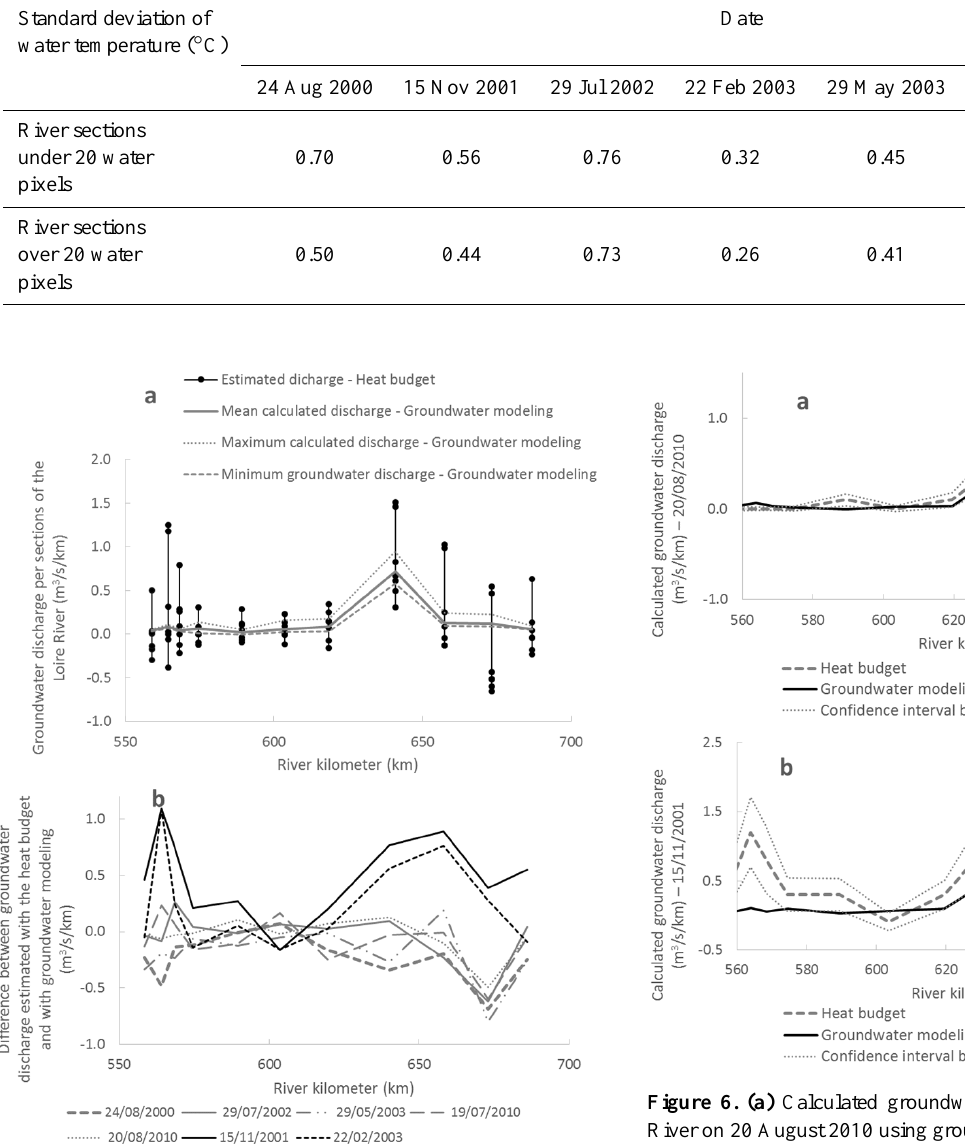
Figure 5. (a) Groundwater discharge per section of the Loire River estimated at the different dates using the heat budget based on the TIR images (black points), and calculated by groundwater model- ing (grey line), as a function of the river kilometers. (b) Absolute value of the difference between groundwater discharges estimated by groundwater modeling and the heat budget.